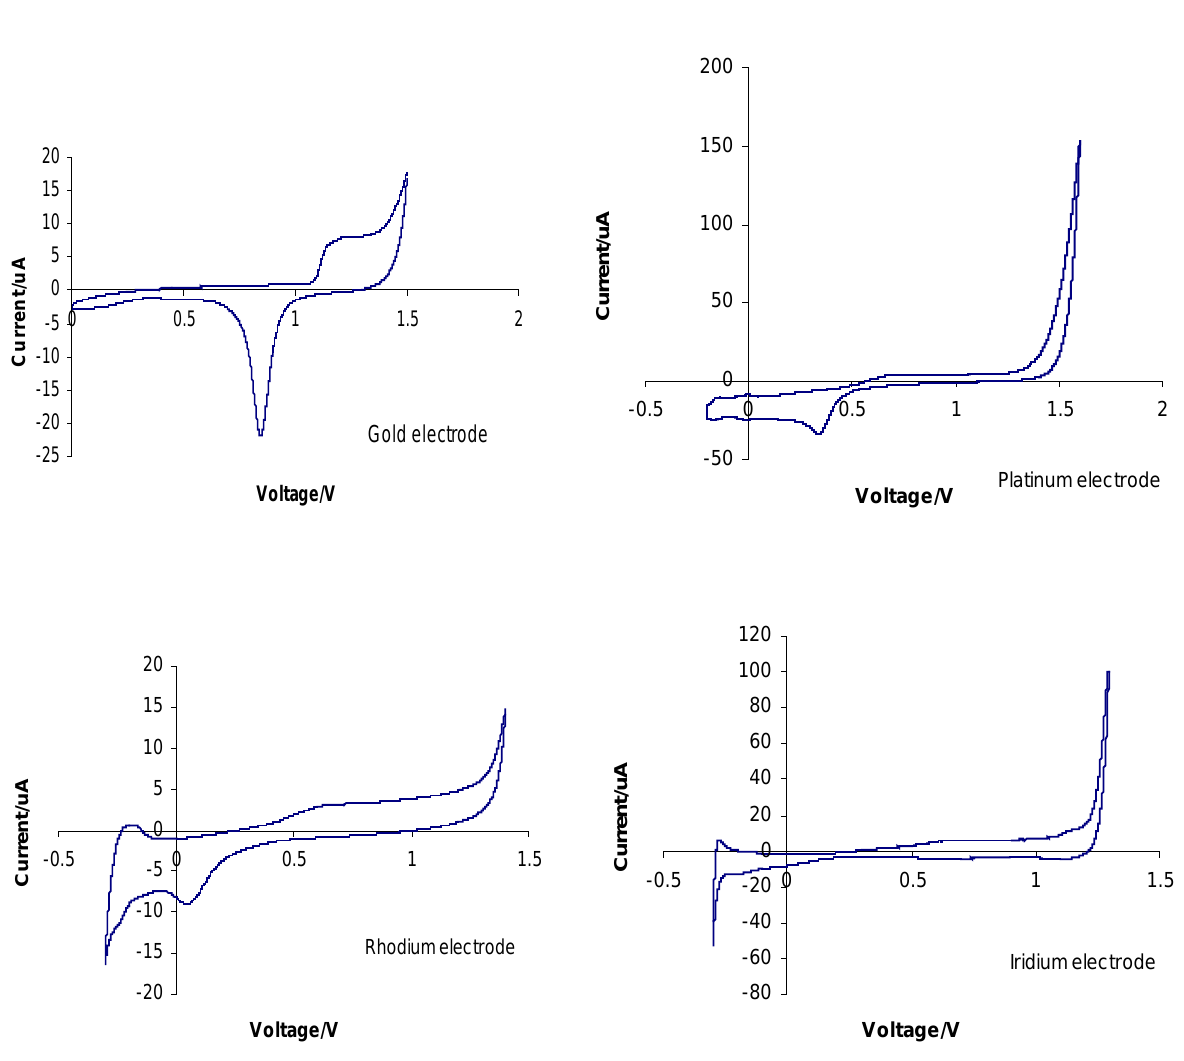
Figure 9. Voltammograms obtained for the working electrodes of the ET sensor in operation in 0.1M sulfuric acid solution at a scan rate of